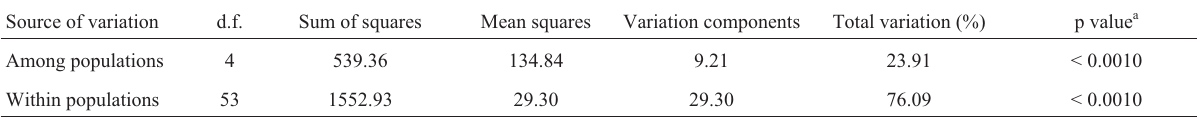
Table 5 - Analysis of molecular variance (AMOVA) for wild, cultivated and all populations of R. tanguticum examined in this work.